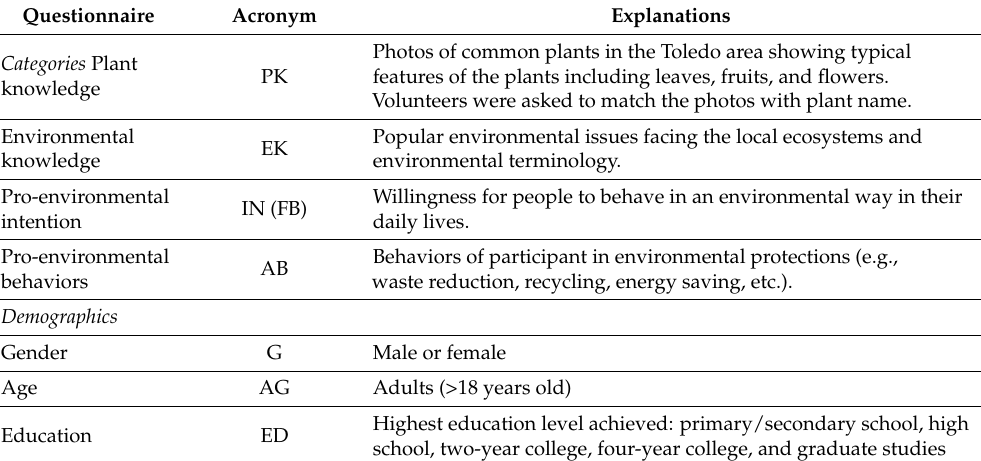
Table 1. The survey questionnaire includes four main categories: plant knowledge (PK), environmental knowledge (EK), pro-environmental intentions (IN); future behaviors (FB), and pro-environmental behaviors (AB). Demographics include gender (G), age (AG), and education (ED).